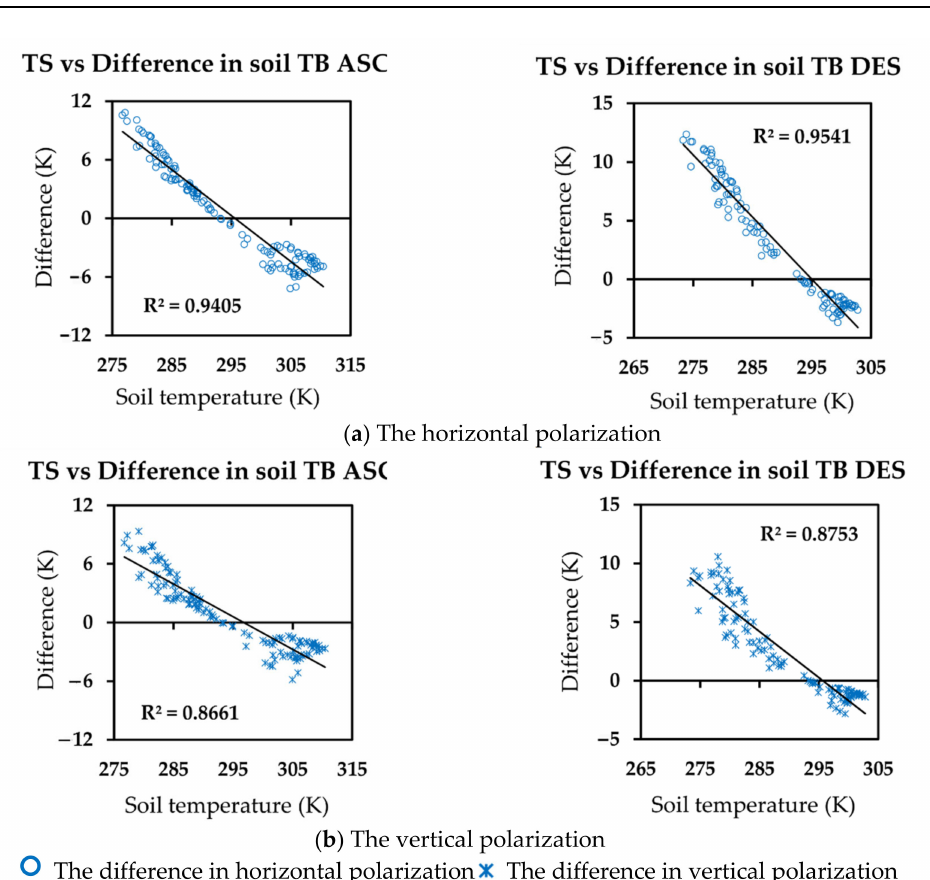
Figure 10. The relationship between soil temperature and the changes of soil TB after the correction at ( a ) horizontal and ( b ) vertical polarizations at both ascending and descending